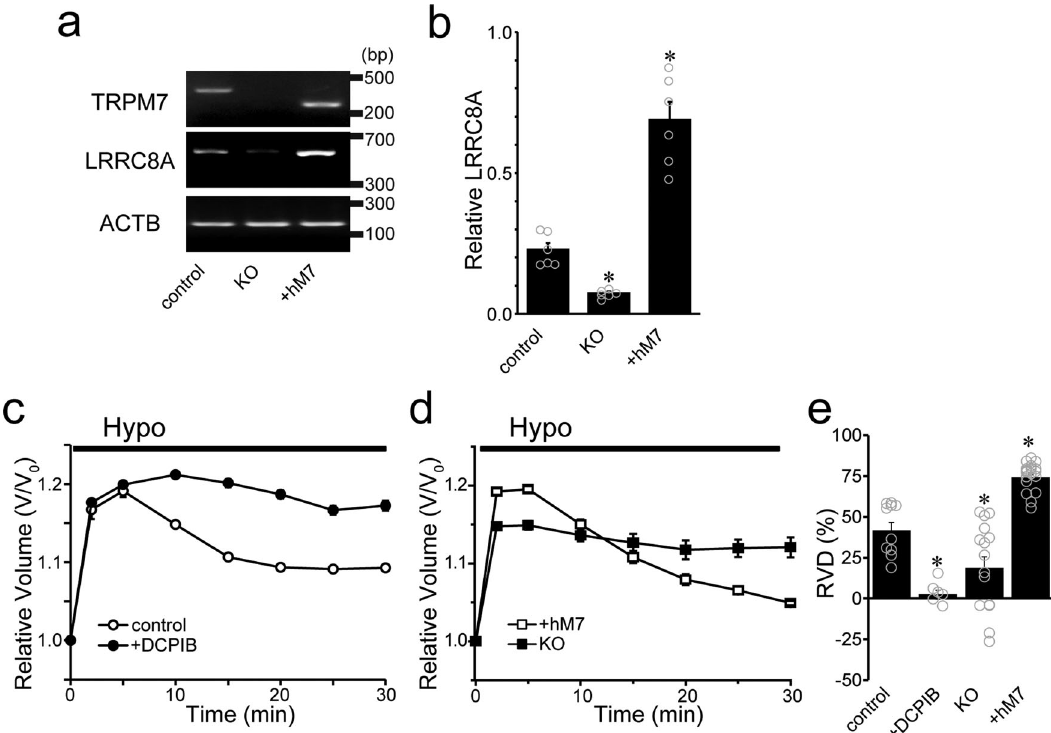
Fig. 7 Effects of gTRPM7 knockout and complementary expression of hTRPM7 on gLRRC8A expression and RVD ef fi cacy in DT40 cells. a PCR products of human or chicken TRPM7, chicken LRRC8A, and the constitutively transcribed control, chicken beta-actin ( ACTB ) in control, gTRPM7-KO DT40 cells ( KO ) and hTRPM7-expressing KO cells ( + hM7 ). The expression of chicken LRRC8A mRNA was greatly decreased in KO cells and increased in + hM7 cells, while that of ACTB stayed almost constant. The nucleotide sequences of the PCR products obtained with TRPM7- and LRRC8A-speci fi c primers were completely identical to the corresponding sequences in TRPM7 (human: NM_017672; chicken: NM_001177555) and LRRC8A (chicken: XM_015279569.2), respectively. b The bar graphs represent the relative expression values of the optical densities in pixels of the PCR bands of gLRRC8A compared to the corresponding band of ACTB control. These values were calculated from six independent PCR ampli fi cations. * P ( = 0.039 and 0.0000021 for KO and + hM7 , respectively) <0.05 compared to control data by one-way ANOVA followed by the post hoc Tukey ’ s test. c, d Time courses of changes in the mean cell volume of WT DT40 cells after a hypotonic challenge ( Hypo : 78% osmolarily). The RVD event was inhibited by DCPIB (10 µ M) ( c ) and gTRPM7-KO ( KO ), whereas it was facilitated in hTRPM7-expressing KO cells ( + hM7 ) ( d ). e Summarized data showing the percent volume recovery (RVD) at 30 min after application of hypotonic solution ( n = 6 – 20). Each data point represents the mean ± SEM (vertical bar) of n samples. * P ( = 0.00035, 0.011, and 0.000070 for + DCPIB , KO , and + hM7 , respectively) <0.05 compared to corresponding data in control data by one-way ANOVA followed by the post hoc Tukey ’ s